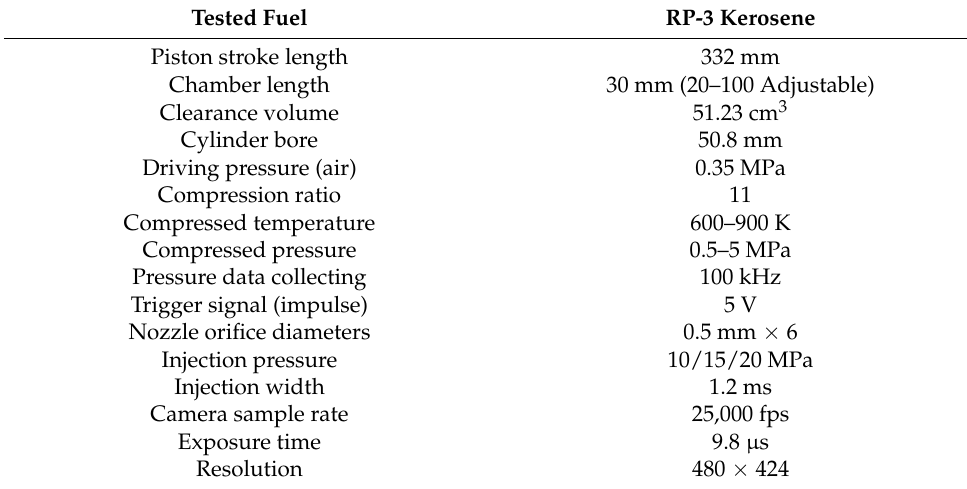
Table 1. Overview of RCM experimental set-up and test conditions.